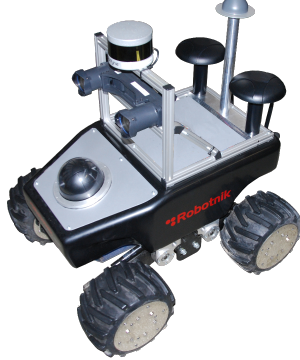
Figure 1. SummitXL UGV by Robotnik